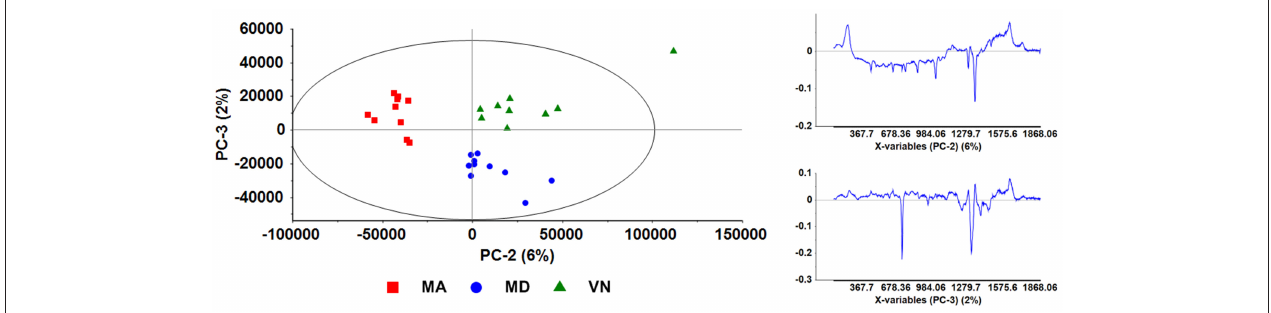
FIGURE 6 | Scores plot depicting PC-2 and PC-3 (left); and loadings plots (right) for both Principal Components, PC-2 (top), and PC-3 (bottom). These plots are for SERS spectra obtained from samples prepared following the “mix-and-read” protocol, with data pre-treatment by BLC.